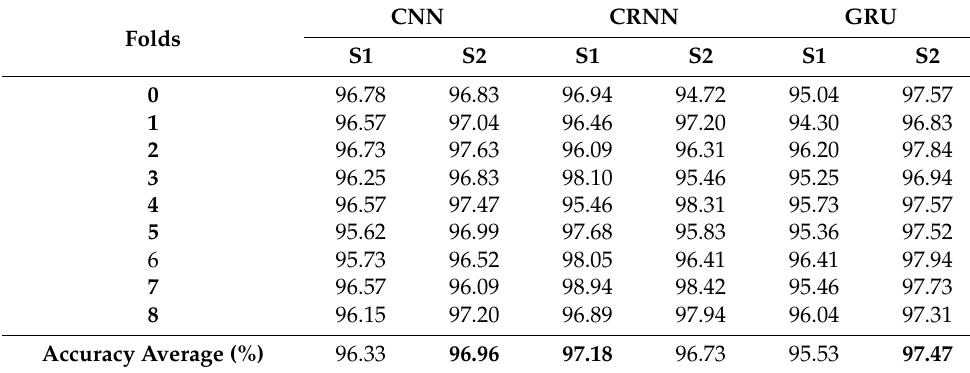
Table 5. Average recognition accuracy for CNN, CRNN, and GRU models. CNN Folds